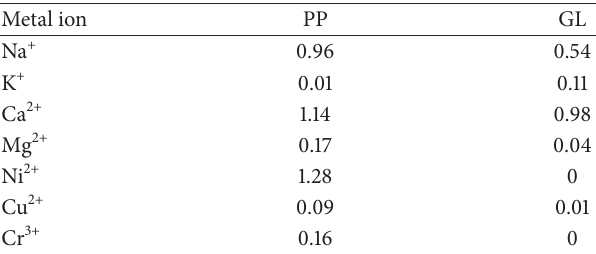
Table 3: Determination of various metal ions.